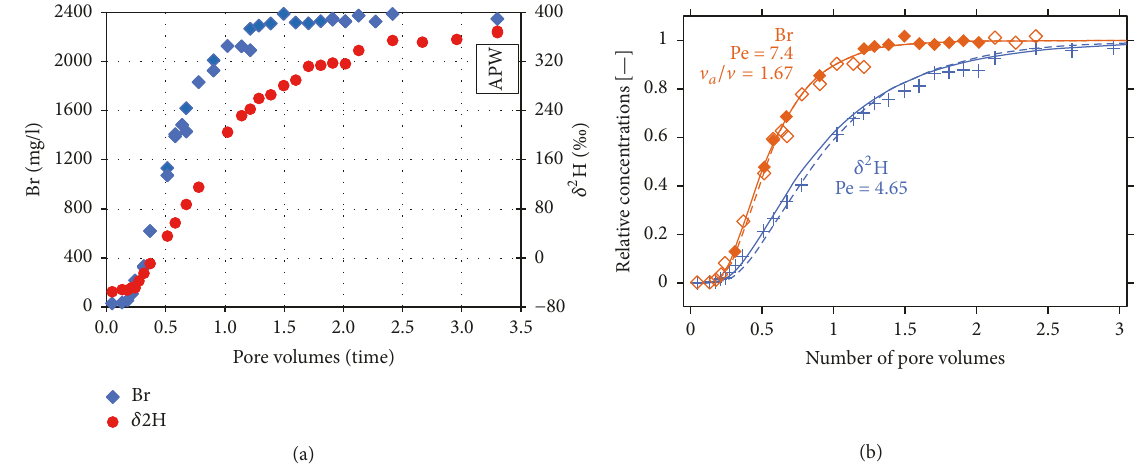
Figure 4: (a) Breakthrough of deuterated water and bromide versus time expressed as pore volume (water content); (b) modelled breakthrough curves with optimum values for P´eclet numbers and the ratio of the anion average linear velocity relative to water, V 𝑎 / V . The dashed lines are for a model including small mixing cells at both ends of the sample, representing the filter